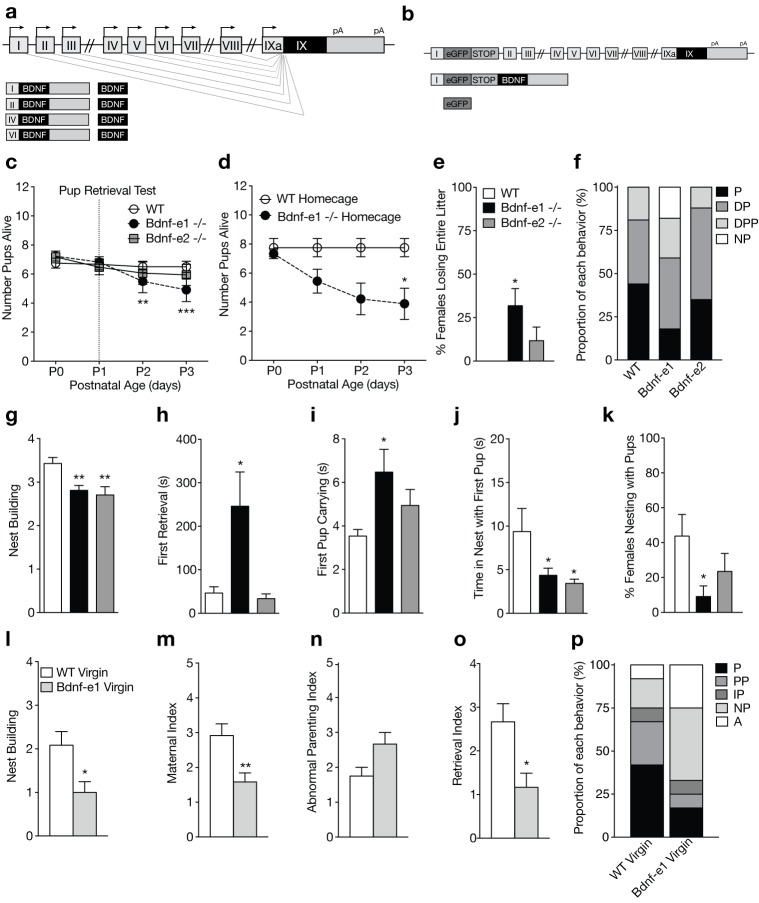
Disruption of BDNF from promoters I and II leads to impaired maternal care.(a) Schematic of Bdnf transcript production. Transcription is initiated from promoters upstream of individual 5’-untranslated regions (UTRs) and spliced to the common coding exon IX. Each transcript produces an identical BDNF protein. (b) Design of Bdnf -/- mice using Bdnf-e1 -/- as a representative example. Targeting vectors were designed to insert an enhanced green fluorescent protein (eGFP) upstream of the exon’s splice donor site. Bdnf-e1 -/- mice express a Bdnf-I-eGFP-STOP-Bdnf IX transcript leading to the production of GFP in lieu of BDNF. (c) Average litter size over time for WT, Bdnf-e1 -/-, and Bdnf-e2 -/- postpartum mothers exposed to the pup retrieval test one day after giving birth. Bdnf-e1 -/- mothers show significant pup loss compared to WT mothers (2-way ANOVA with mixed effect model; p<0.001). (d) Average litter size over time for WT and Bdnf-e1 -/- postpartum mothers remaining in the homecage. Bdnf-e1 -/- mothers show significant pup loss compared to WT mothers even in a naturalistic setting (2-way ANOVA with mixed effect model; p<0.001). (e) Percentage of postpartum mothers losing their entire litter by postnatal day 3 (P3). Approximately 1/3 of postpartum Bdnf-e1 -/- mothers lose their entire litter by P3 (1-way ANOVA with Bonferroni’s multiple comparisons; p<0.05). (f) Proportion of WT, Bdnf-e1 -/- and Bdnf-e2 -/- with different maternal types including parenting (P), disorganized parenting (DP), partial parenting (PP), disorganized partial parenting (DPP), and non-parenting (NP). There is a significant decrease in the proportion of Bdnf-e1 -/- postpartum mothers with parenting behavior compared to WT (one-tailed Mann-Whitney-Wilcoxon rank sum test, p<0.05). Bdnf-e1 -/- postpartum mothers show corresponding elevations in non-parenting behaviors. (g) Bar graph depicting nest building behavior before parturition. Bdnf-e1 and -e2 -/- show impaired nest building compared to WT (Kruskal-Wallis test with Dunn’s multiple comparisons, p<0.01). (h–j) Latency to first retrieval (h) time carrying first pup (i) and time nesting with first pup (j) during the pup retrieval test. Bdnf-e1 -/- postpartum mothers show increased latency to retrieval, longer time carrying the first pup to the nest, and reduced nesting time with first pup (1-way ANOVA with Bonferroni’s multiple comparisons, p<0.05). Bdnf-e2 -/- postpartum mothers show similar, albeit milder phenotypes. (k) Percentage of postpartum mothers successfully retrieving all pups and nesting for at least 2 continuous minutes. Significantly fewer Bdnf-e1 -/- postpartum mothers successfully retrieve pups and continuously nest compared to WT (1-way ANOVA with Bonferroni’s multiple comparisons, p<0.05). (l) Bar graph depicting nest building behavior of WT and Bdnf-e1virgins 24 hr prior to pup retrieval test. Bdnf-e1 -/- virgins show impairments in nest building compared to WT virgins (Mann-Whitney test, p<0.05). (m–o) Maternal (m), abnormal parenting (n) and retrieval (o) indices for WT and Bdnf-e1 -/- virgins during foreign pup retrieval test. Bdnf-e1 -/- virgin females show reductions in maternal and retrieval indices and a strong trend for increased abnormal parenting (Mann-Whitney tests, p<0.01, p<0.05, and p=0.0529, respectively). (p) Proportion of WT and Bdnf-e1 -/- virgin females with different maternal types including parenting (P) partial parenting (PP), irregular parenting (IP), non-parenting (NP), and attack (A). There is a significant decrease in the proportion of Bdnf-e1 -/- virgins with parenting behavior compared to WT. Bdnf-e1 -/- virgins show corresponding elevations in attack behavior (one-tailed Mann-Whitney-Wilcoxon rank sum test, p<0.05). Data are means ± SEM. (n = 16 WT postpartum mothers; n = 22 Bdnf-e1 -/- postpartum mothers; n = 17 Bdnf-e2 -/- postpartum mothers; n = 12 WT virgins; n = 12 Bdnf-e1 -/- virgins; *p<0.05, **p<0.01, and p<0.001, #p<0.0001).